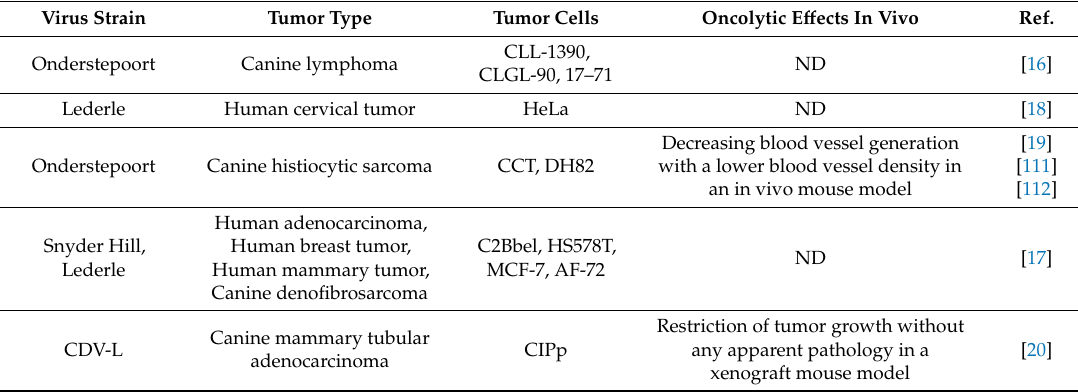
Table 2. Summary of CDV strains used for